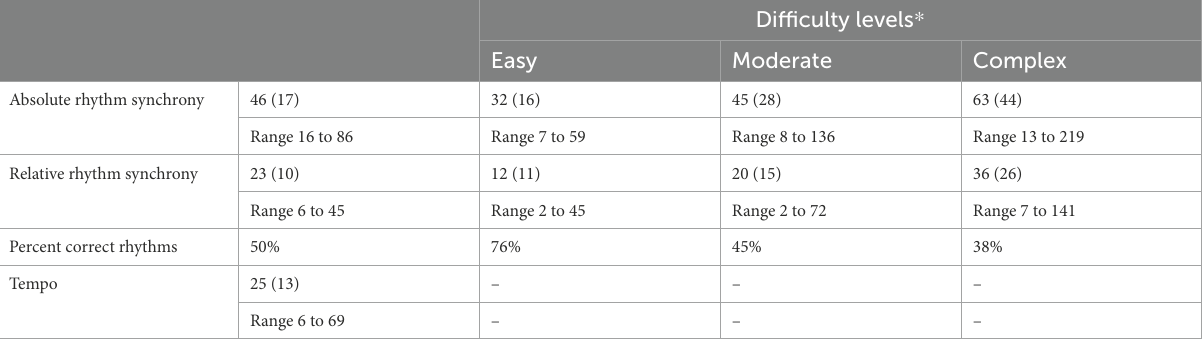
TABLE 4 Means and standard deviations of the temporal deviations in the tempo reproduction and rhythm reproduction tasks of the Tapping- PROMS by task difficulty